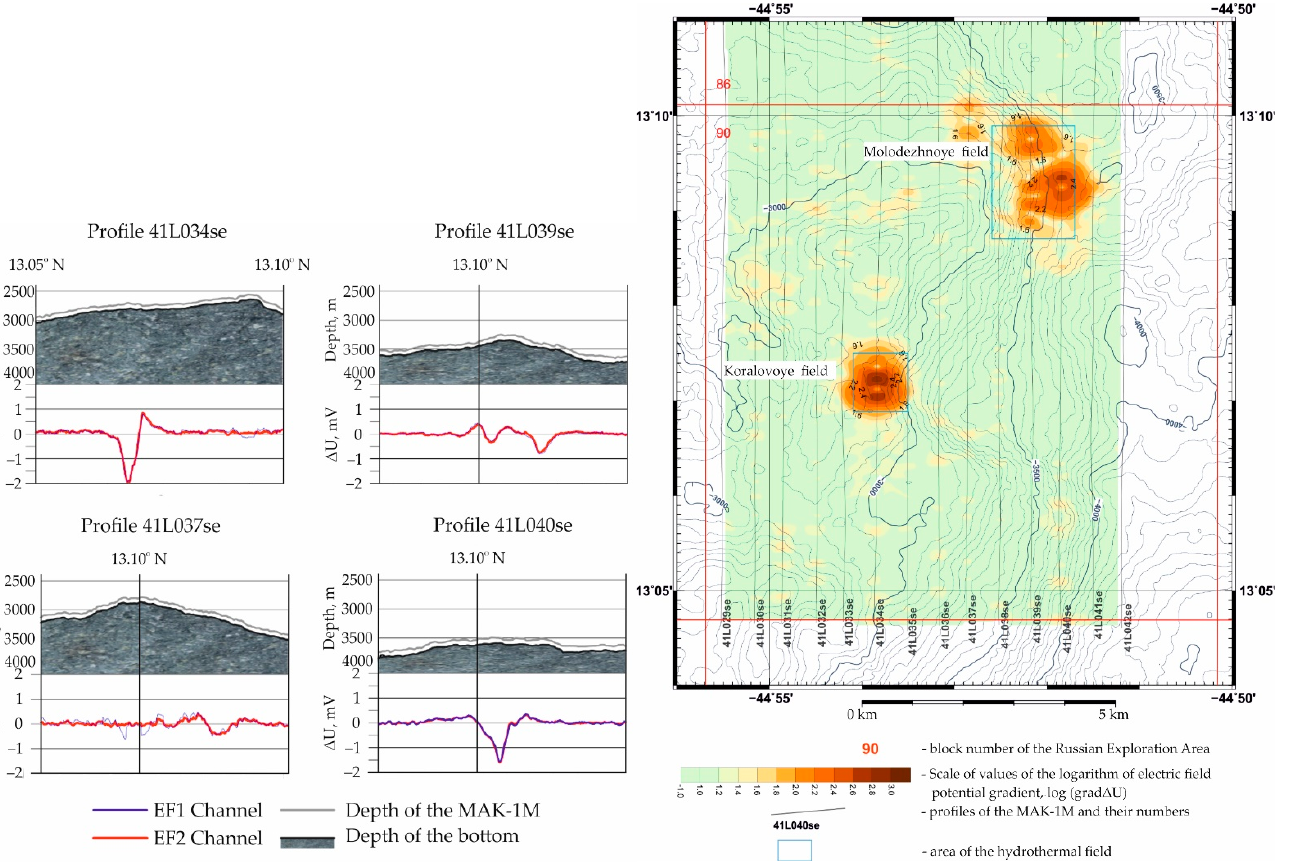
Figure 4. ( Left ) the EF anomalies on profiles; ( right ) scheme of the logarithm of the gradient Δ U. The Molodezhnoye and Koralovoye HF’s. Molodezhnoye and Koralovoye